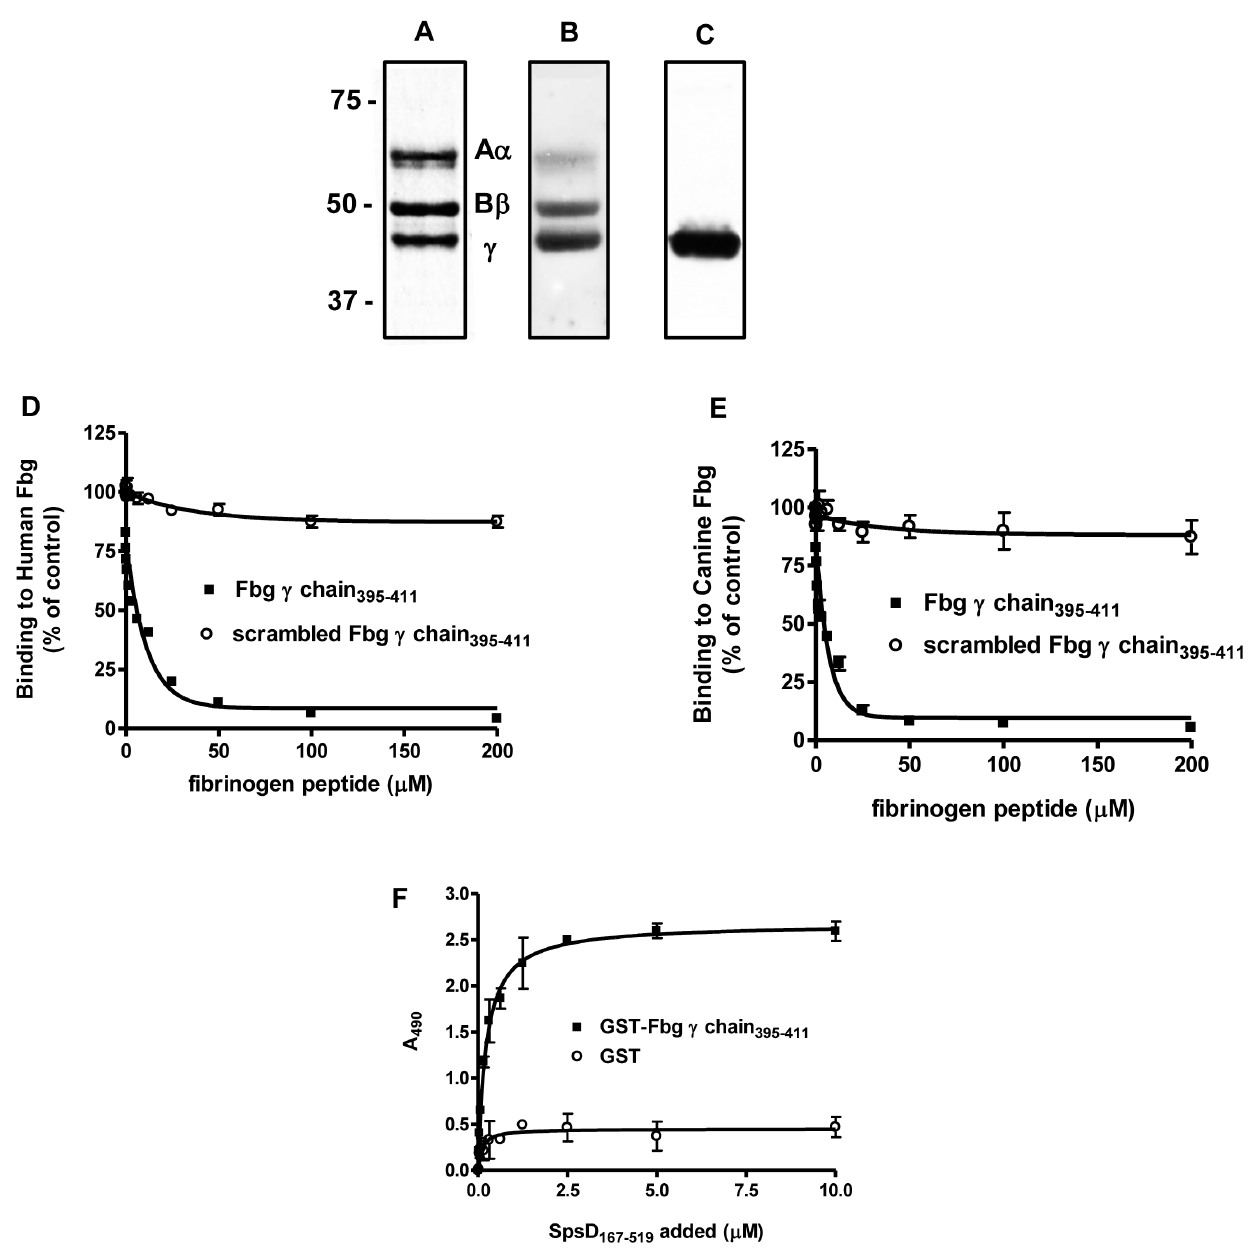
Figure 4. SpsD recognizes Fbg c chain. (A), human Fbg was subjected to SDS-PAGE in reducing conditions and then stained with Coomassie Blue. (B), Fbg was subjected to SDS-PAGE in reducing conditions, transferred to a nitrocellulose membrane and Fbg chains detected by incubation of the membrane with anti-mouse Fbg IgG and then HRP-conjugated rabbit anti-mouse IgG. (C), Fbg was subjected to SDS-PAGE under reducing conditions, electroblotted onto nitrocellulose filter and probed with SpsD 167–519 followed by incubation with mouse anti-SpsD IgG and HRP- conjugated rabbit anti-mouse IgG. (D) and (E), effect of the Fbg C-terminal c chain peptide on the binding of SpsD 167–519 protein to immobilized Fbg. Surface-coated human (D) or canine (E) Fbg was incubated with SpsD 167–519 in the presence of increasing concentrations of the 17- mer synthetic peptide of the c chain. The effect of a scrambled peptide on Fbg-SpsD 167–519 interaction is also reported as control; the assay was performed as in (C). (F), dose-dependent binding of SpsD 167–519 protein to immobilized GST fused to the Fbg C-terminus of c chain. Microtiter wells were coated with GST-Fbg c chain and probed with increasing concentrations of SpsD 167–519 . Complex formation was detected by addition of mouse anti- 6-His IgG followed by HRP-conjugated rabbit anti-mouse IgG. Values are the means 6 S.E of triplicate wells and are representative of one experiment. This experiment was performed three times with similar results. doi:10.1371/journal.pone.0066901.g004 Following additional washings with 0.5% (v/v) Tween 20 in PBS incubated for 45 min with HRP-conjugated rabbit anti-mouse (PBST), the membrane was incubated for 1 h with PBST IgG. Finally, the membrane was treated with ECL detection containing an anti-His tag mouse monoclonal antibody (7E8) reagents 1 and 2 according to the procedure recommended by the (2 m g/ml). After several washings in PBST, the membrane was